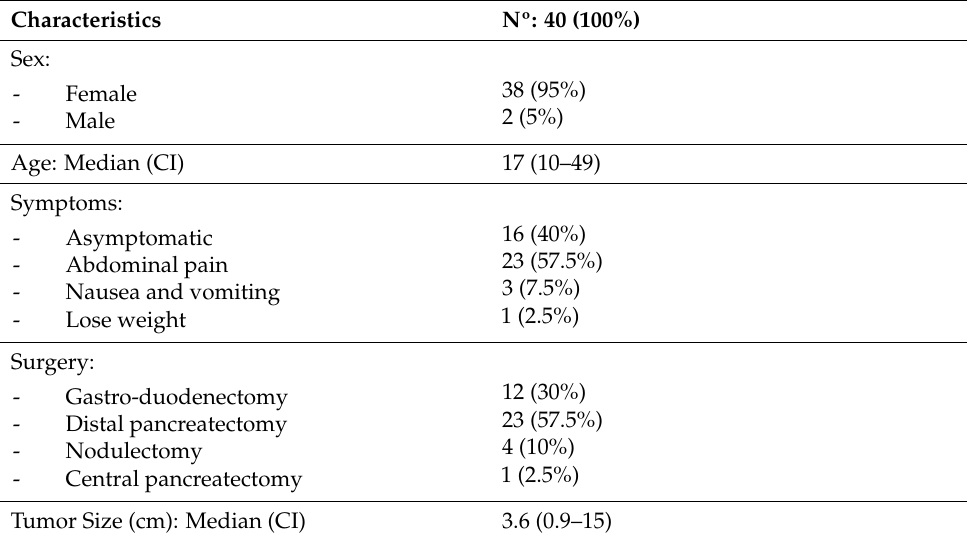
Table 1. Demographic characteristics of patients.